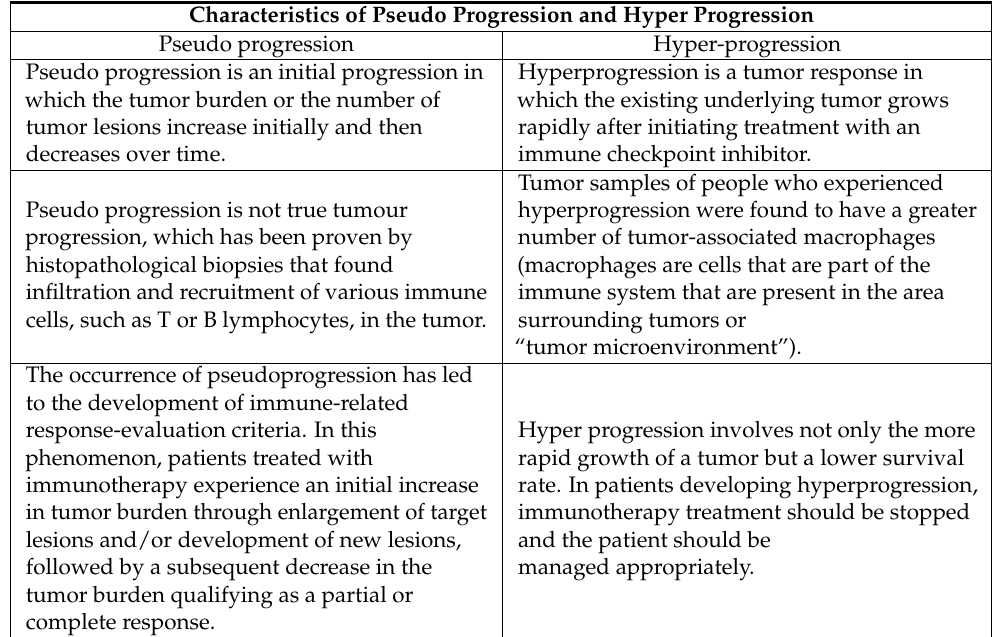
Table 1. Characteristics of pseudo progression and hyper